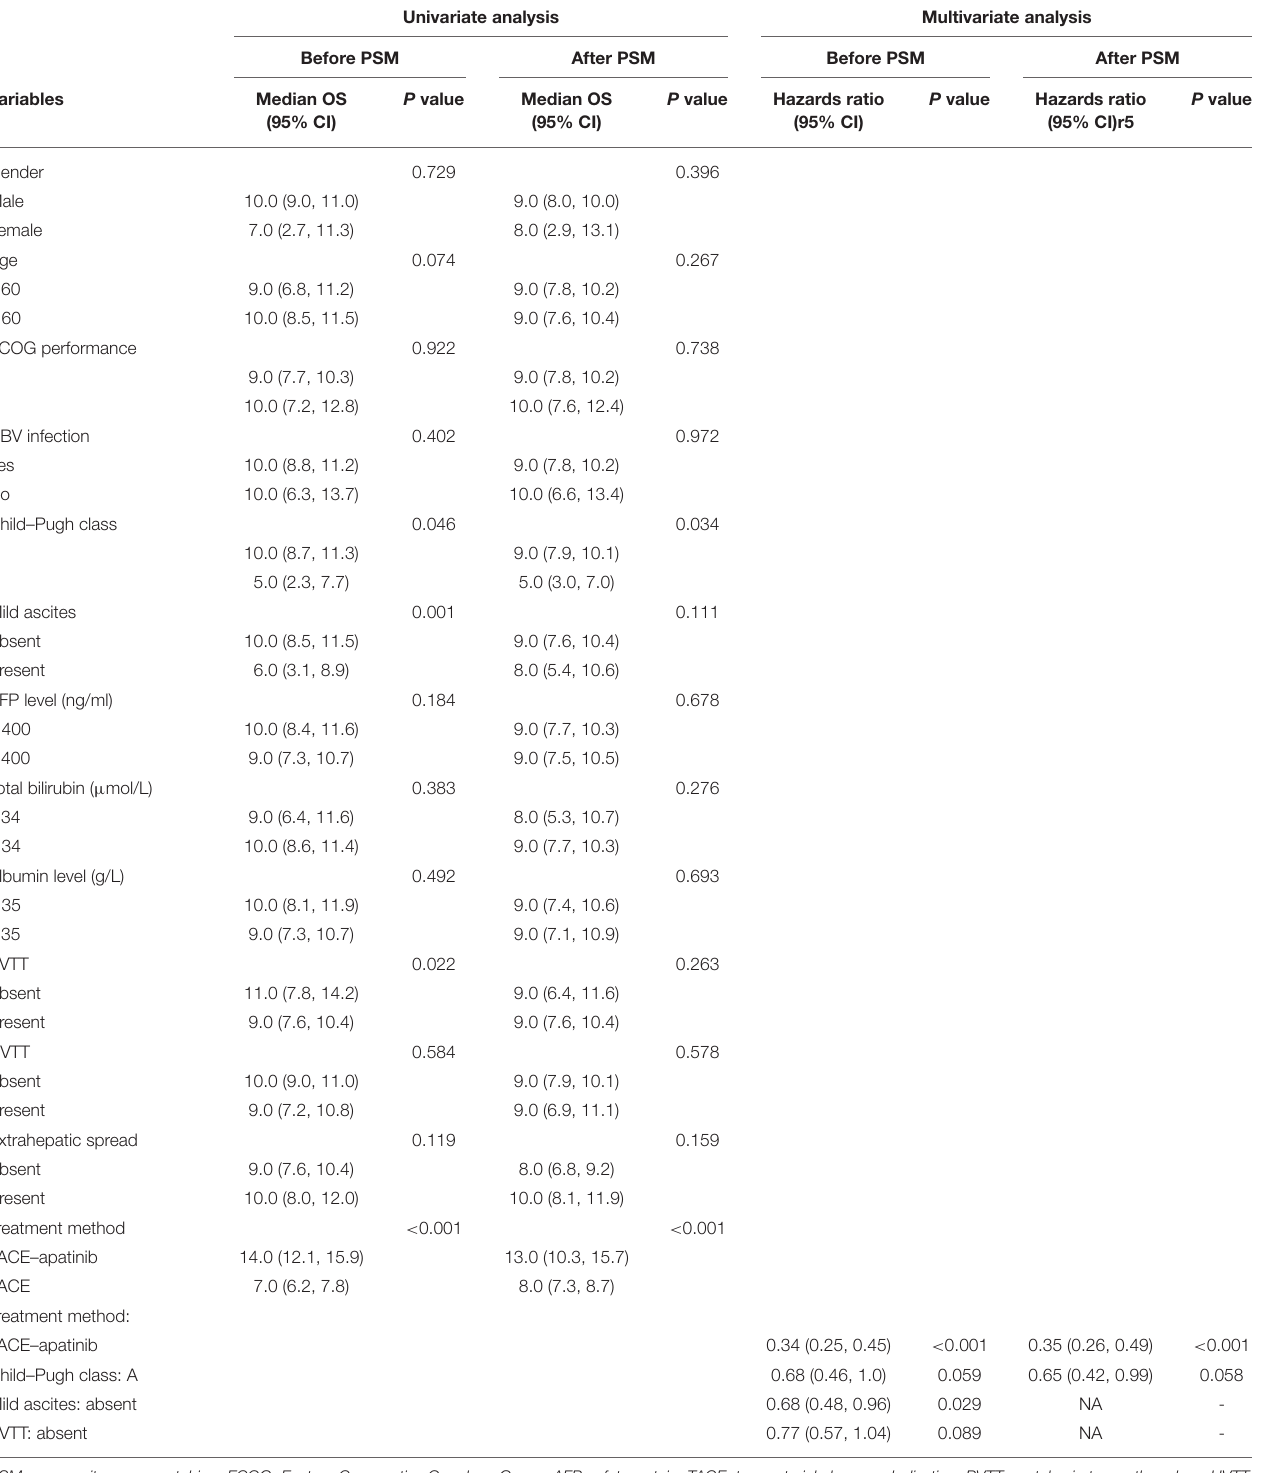
TABLE 6 | Univariate and multivariate analysis of prognostic factors for overall survival (OS) before and after PSM analysis. Univariate analysis Multivariate analysis Before PSM After PSM Before PSM After